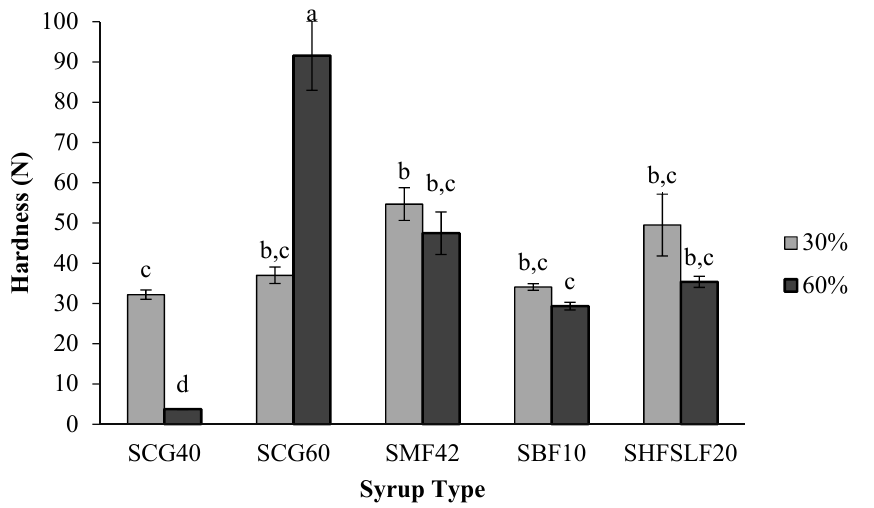
Figure 3. Effect of corn syrup type and concentration on the hardness of the formulated candies. Small letters indicate the significant differences ( p < 0.05) between the samples. Each bar represents a different sample. Errors are represented as standard errors.